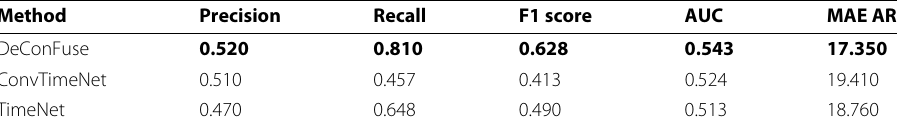
Table 4 Summary of trading